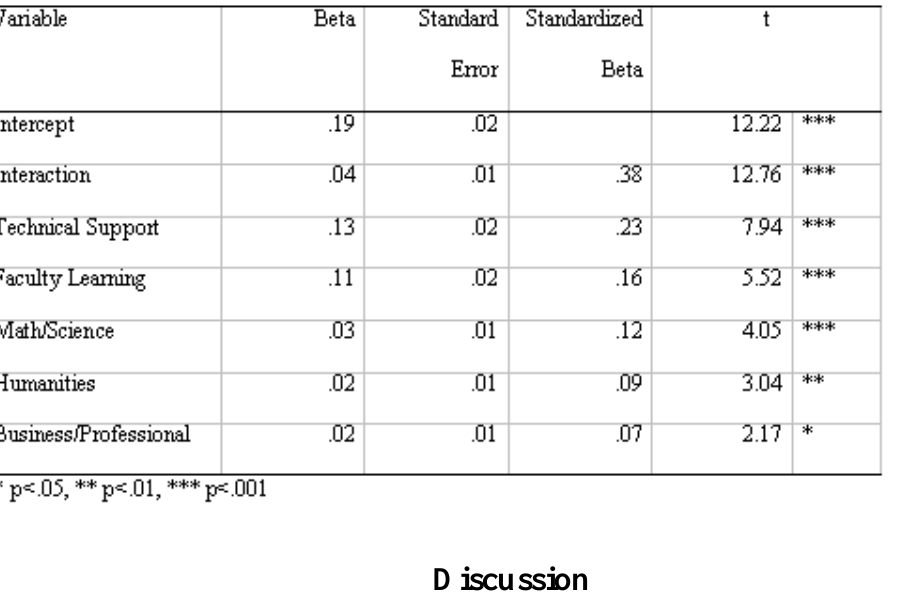
Table 9. Contributions of Predictors to Faculty Online Teaching